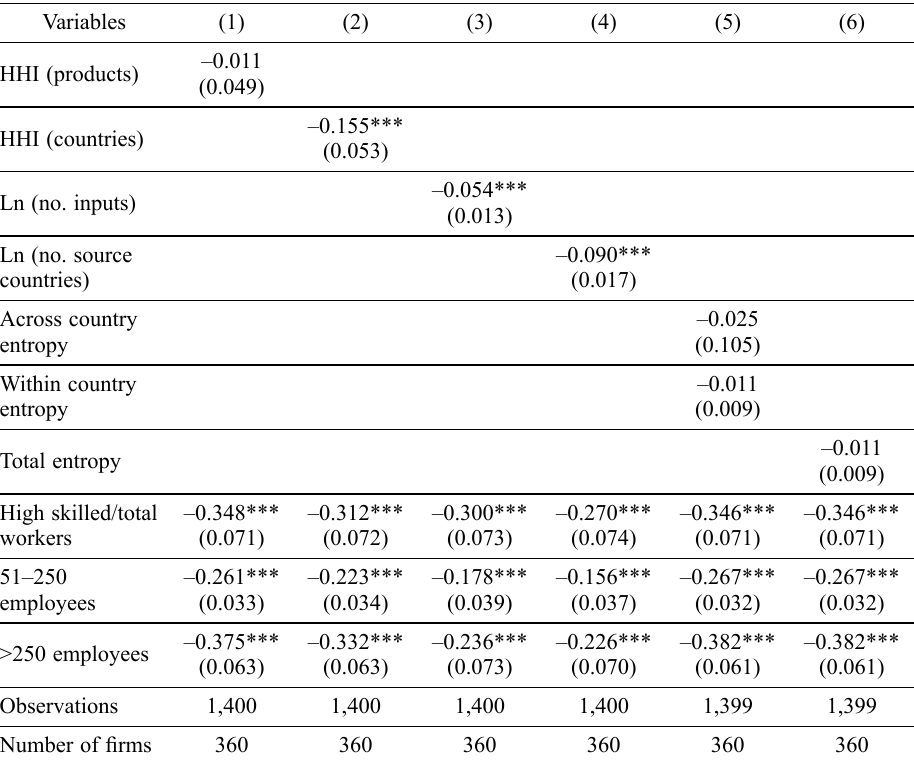
Table 3. Global sourcing and distance to the industry frontier